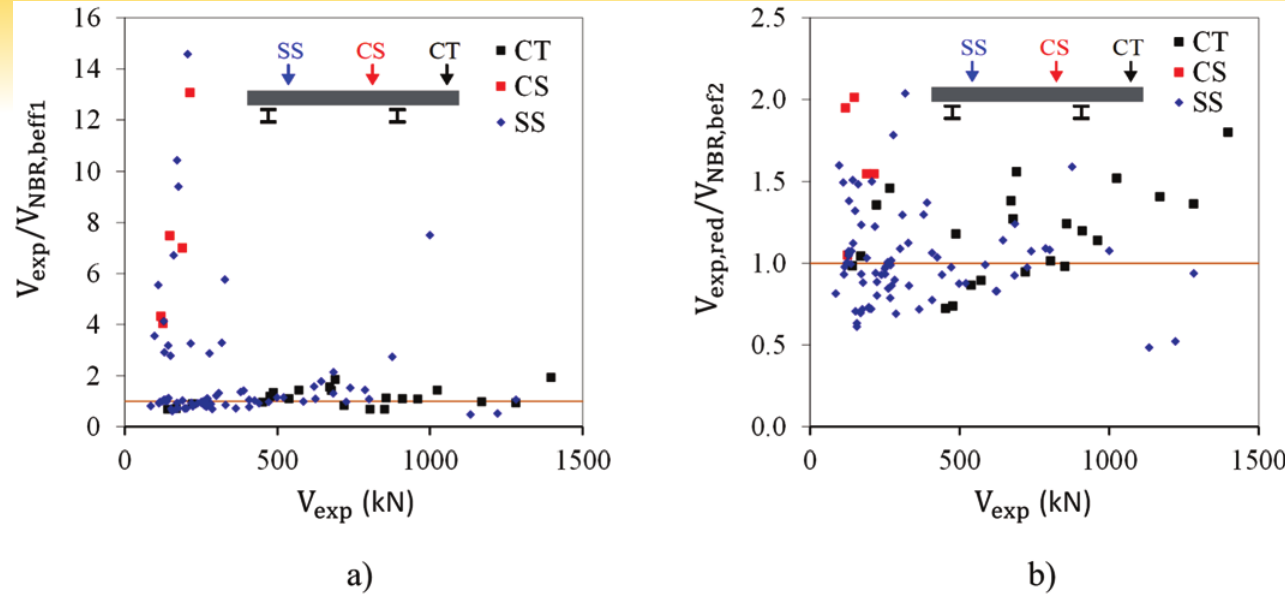
Effect of loading typology in the case of: a) No consideration of factor β b) With the factor β